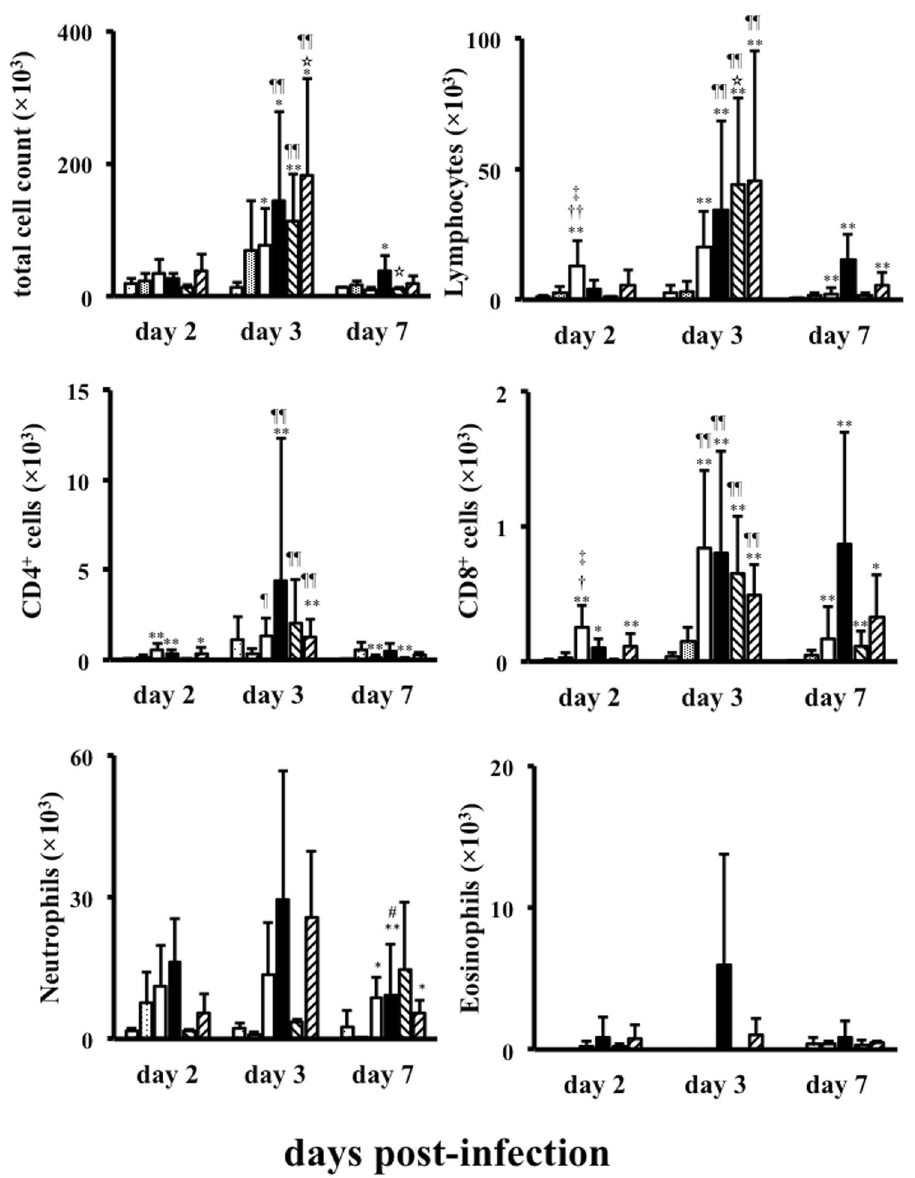
Figure 2. The number of infiltrated cells in BAL fluid after influenza infection. Cell infiltration in BAL fluid from control and asthmatic mice infected with vehicle (mock), A(H1N1)pdm09, or seasonal H1N1 (A/Puerto Rico) at 2, 3, and 7 days post-infection as determined by flow cytometry and cytospin samples. Data are the mean ± standard deviation (SD) of three independent experiments. : control/A(H1N1)pdm09, : asthma/A(H1N1)pdm09, : control/seasonal, : asthma/seasonal, : control/mock, : asthma/mock. Control/A(H1N1)pdm09 vs. asthma/ A(H1N1)pdm09: † p < 0.05, †† p < 0.01; control/seasonal vs. asthma/seasonal: || p < 0.05, || || p < 0.01; control/ A(H1N1)pdm09 vs. control/seasonal: * p < 0.05; asthma/A(H1N1)pdm09 vs. asthma/seasonal: § p < 0.05, §§ p < 0.01; asthma/A(H1N1)pdm09 vs. control/seasonal: $$ p < 0.01; and control/A(H1N1)pdm09 vs. asthma/seasonal: ‡ p < 0.05, ‡‡ p < 0.01; mock group vs. each group: * p < 0.05, ** p < 0.01; day 2 vs. day 3, ¶¶ p < 0.01; day 3 vs. day 7: ## p <